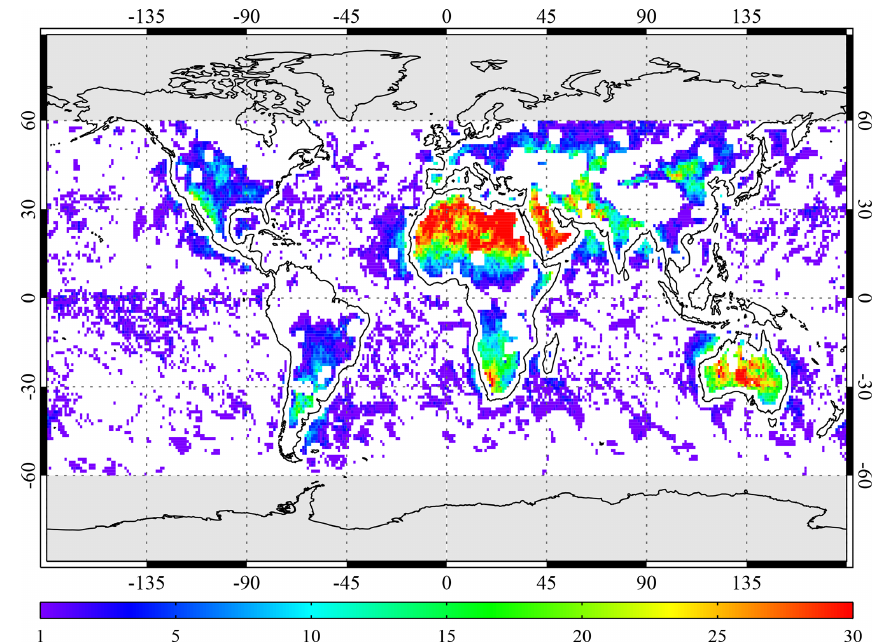
Figure 3. Location and frequency of the 1 ◦ × 1 ◦ cloud-free latitude–longitude boxes that were selected by the algorithm every 2 weeks for the period from May 2018 until May 2020. A total of 56d contributed to the image. The selection and filtering approach is described in Sect. 4.4.